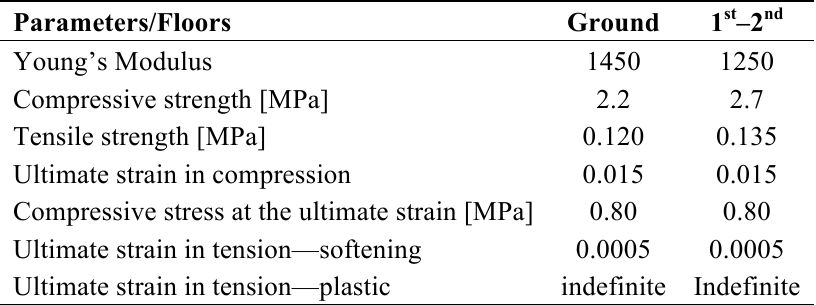
Table 4. Mechanical parameters of masonry for non-linear